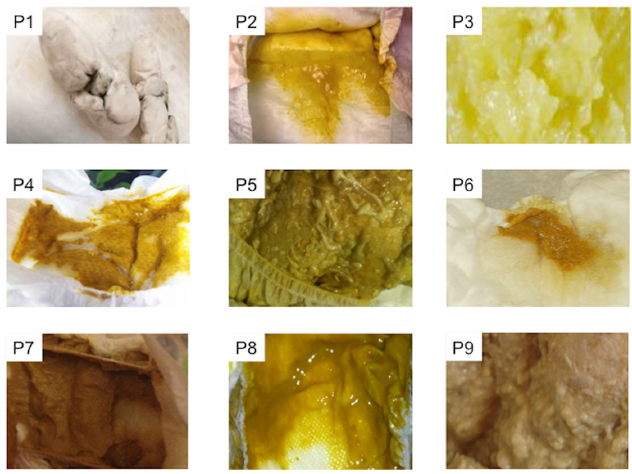
Fig 3. Example of stool photographs presented to panel of pediatricians for development of gold